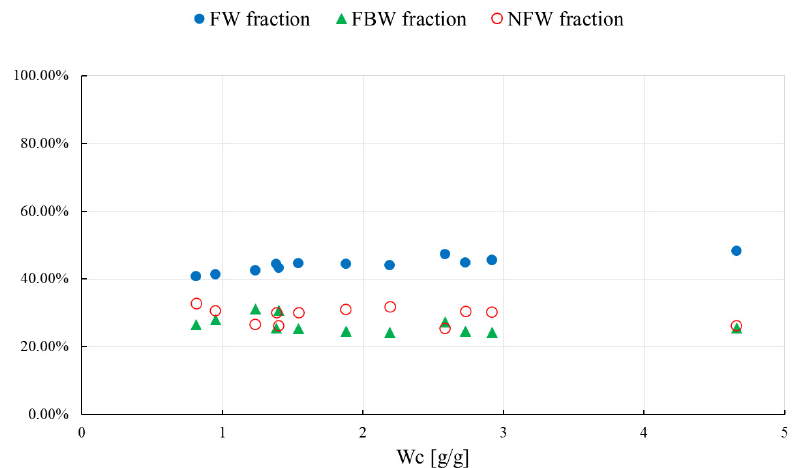
Figure 8. HPC/SA mixtures: percentage of the fractions of water in the mixture as a function of water concentration W c . The blue circles indicate the FW fraction, the green triangles the FBW fraction, the red empty circles the NFW fraction.